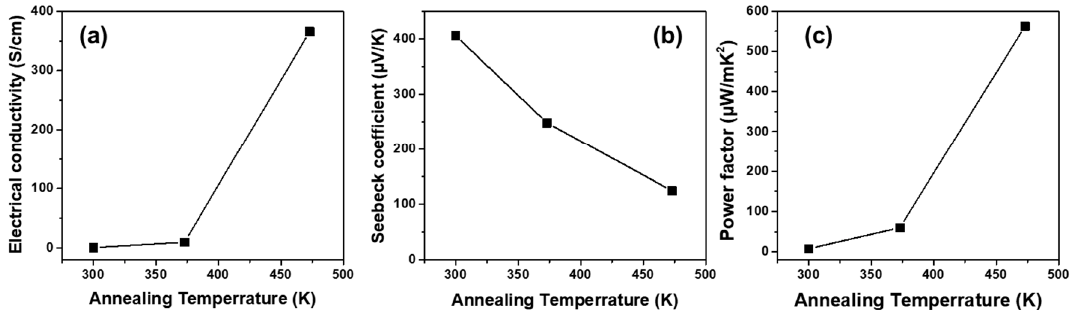
Figure 3. ( a ) Electrical conductivity, ( σ ), ( b ) Seebeck coefficient, ( S ), and ( c ) power factor as functions of annealing temperature (373, 473 K) for 100 nm thick Sb 2 Te 3 films deposited on polished glass substrates at room temperature (300 K).